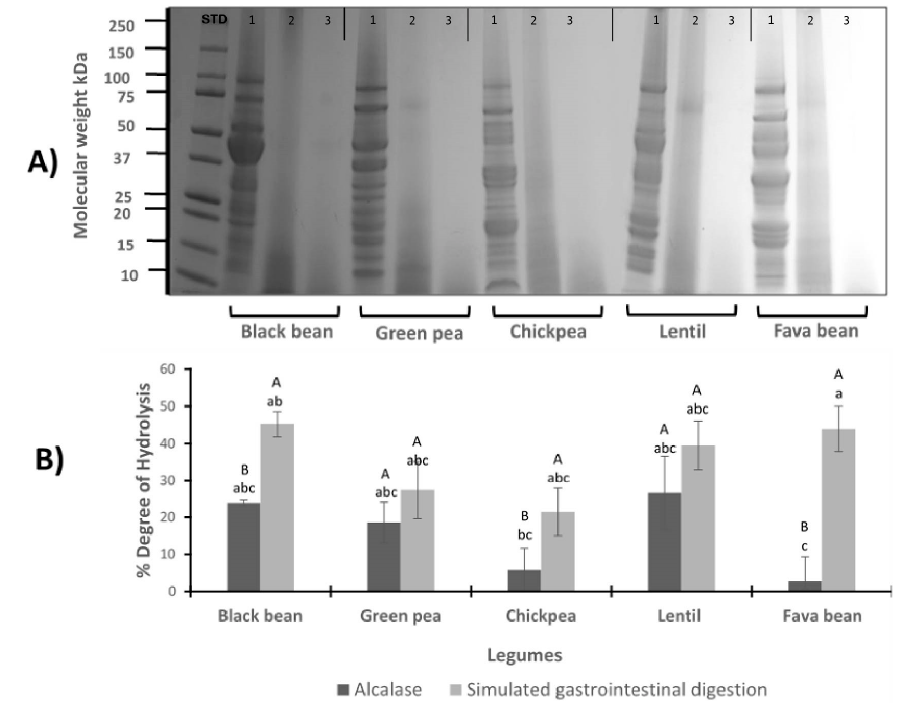
Figure 1. ( A ) Electrophoretic SDS–PAGE profile of legumes. Protein profile of black bean, green pea, chickpea, lentil and fava bean, before and after hydrolysis with alcalase and simulated gastrointestinal digestion. Each sample is presented in 3 wells: 1st well belongs to LPI profile (1), 2nd belongs to protein isolate after hydrolysis with alcalase (2), and the 3rd belongs to protein isolate after pepsin/pancreatin digestion (3). STD: standard. ( B ) Degree of hydrolysis (%) of legume protein isolates hydrolyzed with alcalase (A-LPH) and after simulated gastrointestinal digestion with pp (PP-LPH). Different uppercase letters indicate significant differences between alcalase and pepsin/pancreatin digestion ( p < 0.05); different lowercase letters indicate significant differences ( p < 0.05) among legume protein hydrolysates. Results represent the mean ± SD of at least two independent